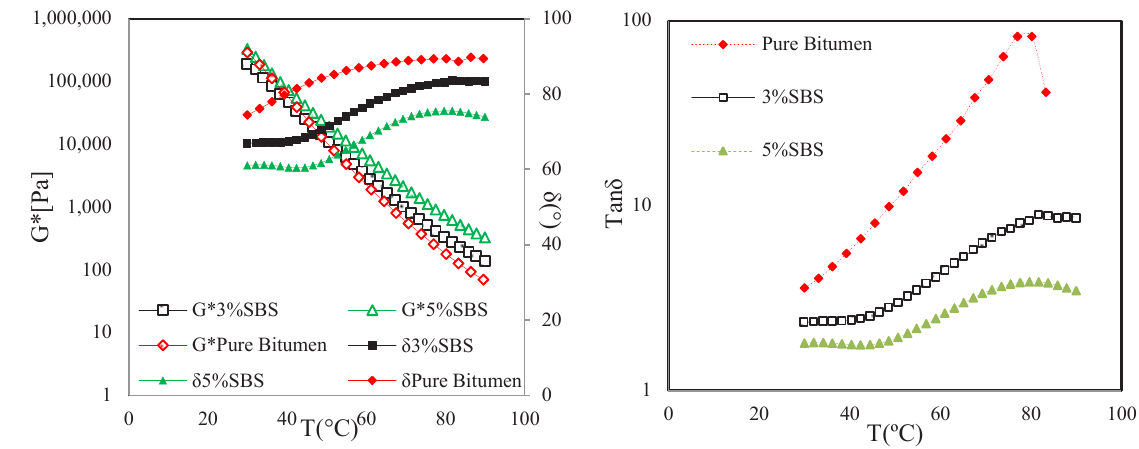
Fig. 6. Complex modulus/phase angle (left) and Tanδ (right) curves for the bitumen modified by